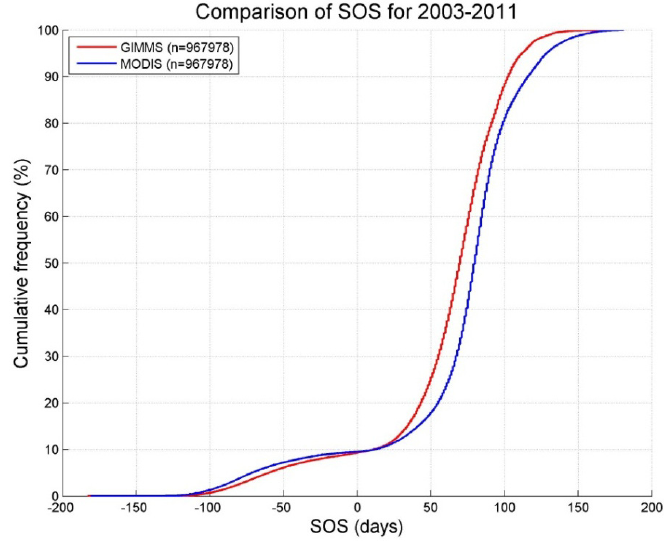
Figure 9. Cumulated distribution function of the pixel-wise estimated start of season (SOS) for GIMMS (red) and MODIS (blue) for all years (2003–2011) using the relative threshold approach. Smoothed products at daily temporal resolution were used for the calculations. SOS of zero corresponds to a turn of the year.